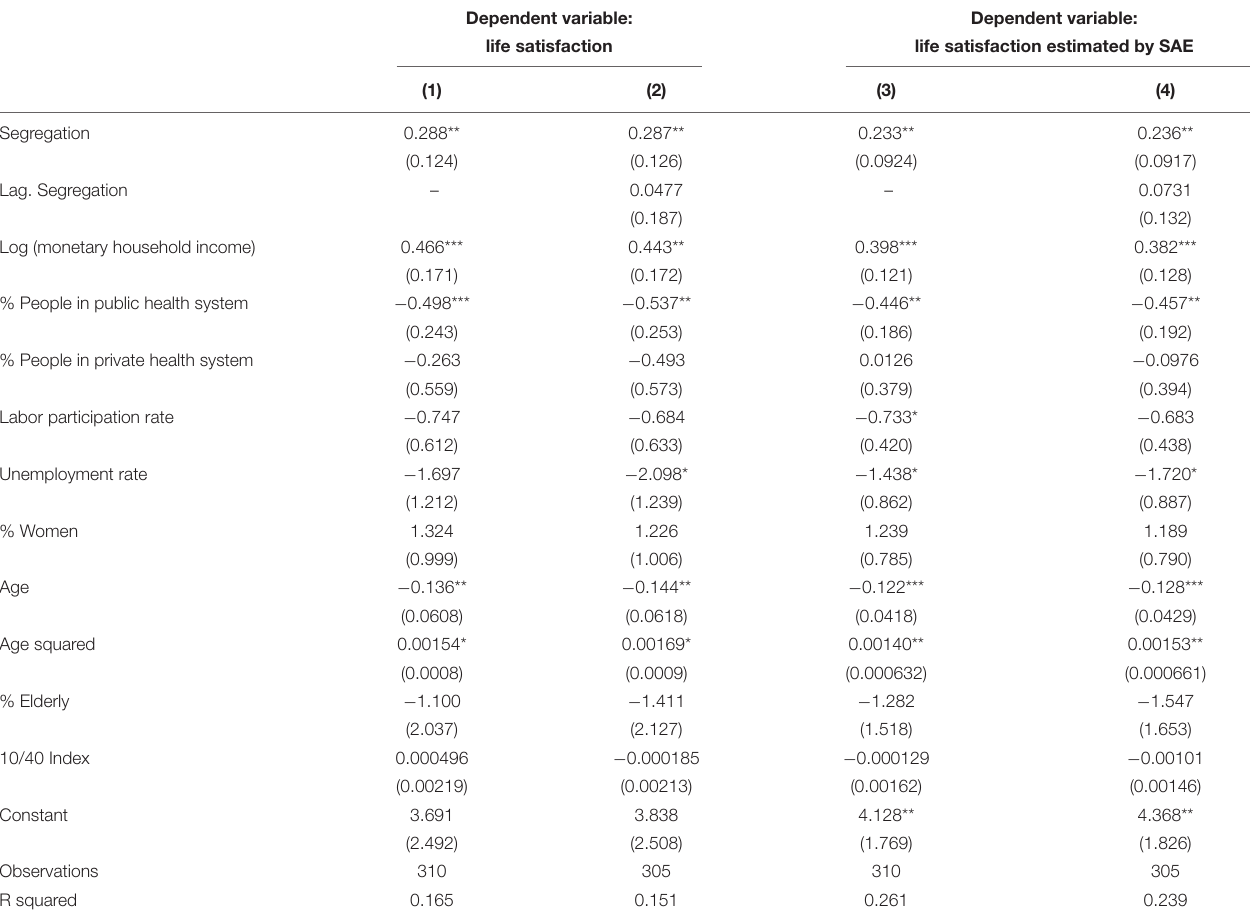
TABLE 4 | Determinants of life